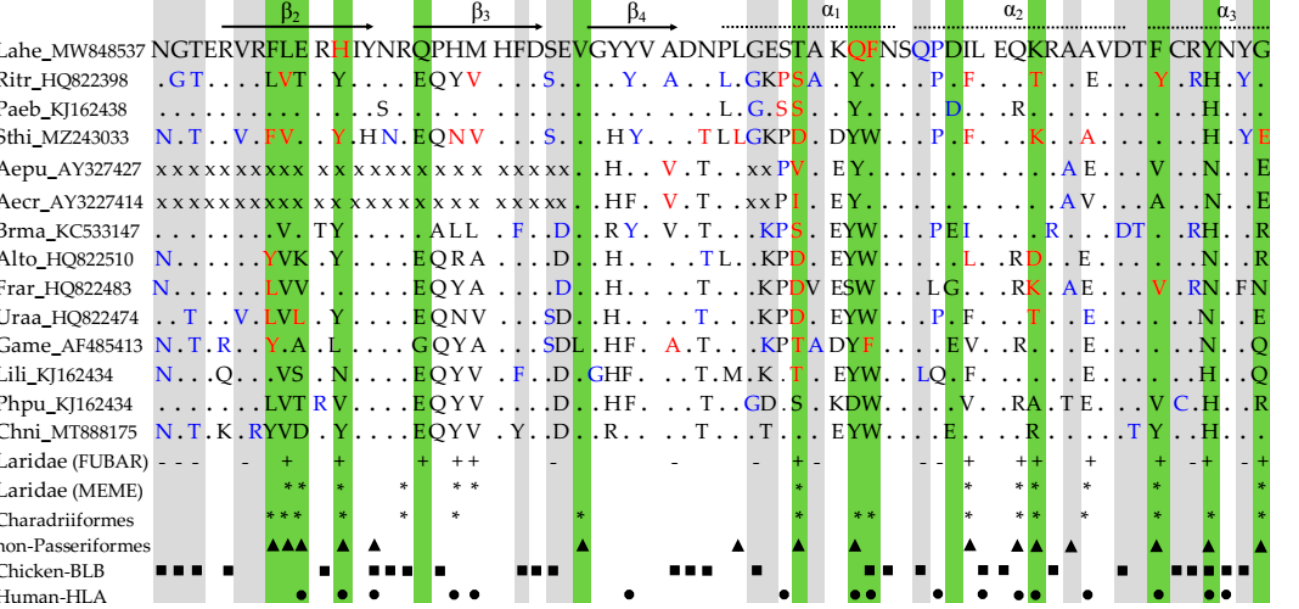
Figure 5. Alignment of amino acids from Heermann’s Gull MHCIIB and other Charadriiformes. Dots indicate the same residues as in Lahe_MW848537. ‘x’ represents missing amino acids. FEL assessed the sites under diversifying (in red) and purifying (in blue) selection for each species. FUBAR detected the sites under positive and negative selection separately for Charadriiformes (shaded in green and gray, respectively) and Laridae (indicated with + or − respectively). Amino acids under diversifying selection for Charadriiformes and Laridae identified by MEME ( p = 0.05) are marked with *. The triangles show the sites under positive selection inferred for non-passerines [33], while the dots show the peptide-binding residues in humans [46,47]. The squares show conserved sites in the alignment of α and β domains (highlighted by upper arrows and dotted lines) in representative mammals and the BLB2 chain from chicken [45]. Lahe— Larus heermanni ; Ritr— Rissa